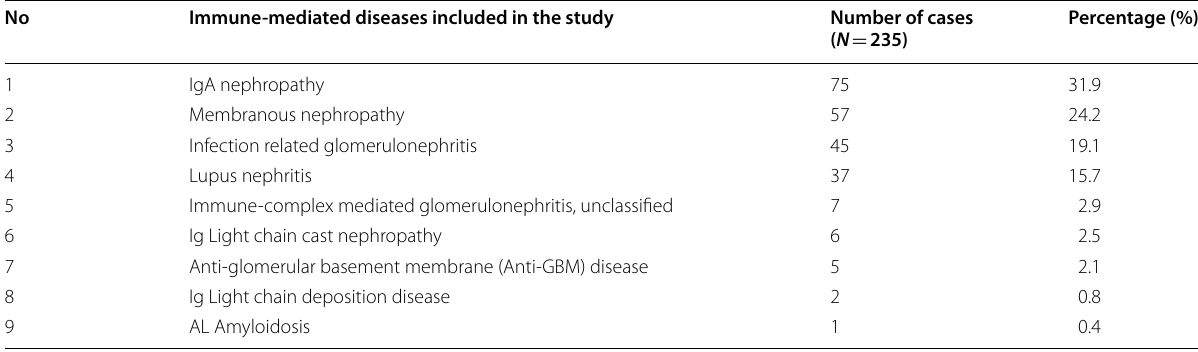
Table 2 Distribution of immune-mediated diseases included in the study